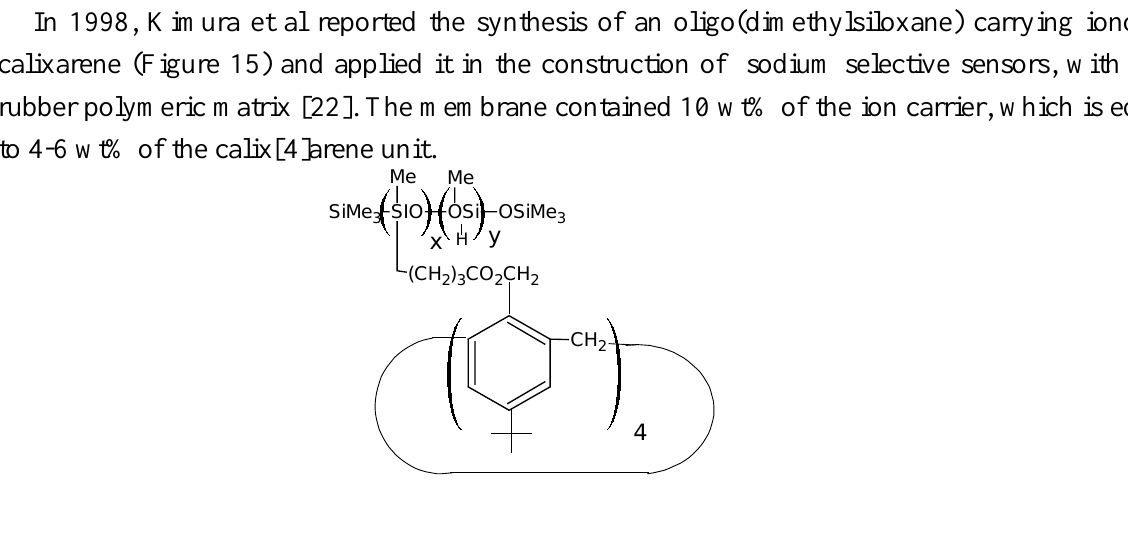
Figure 15. Oligo(dimethylsiloxane) carrying ionophorous calixarene. L. A. Muslinkina reported Calix[4]resorcinarene to be applied as an ionophore in the